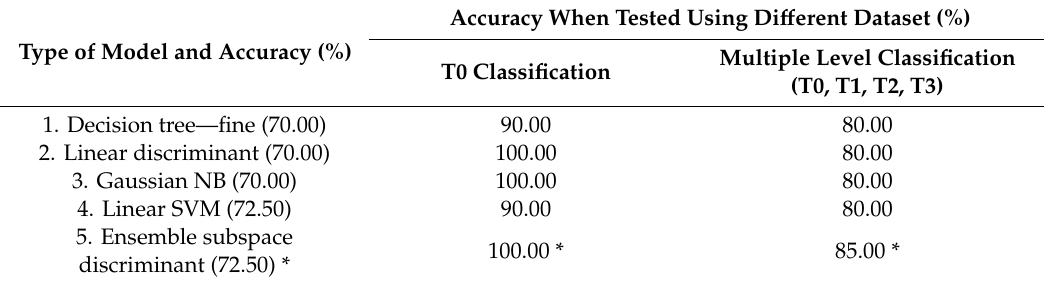
Table 6. Results of the classification model using PC1, PC2, and PC3 (variance of